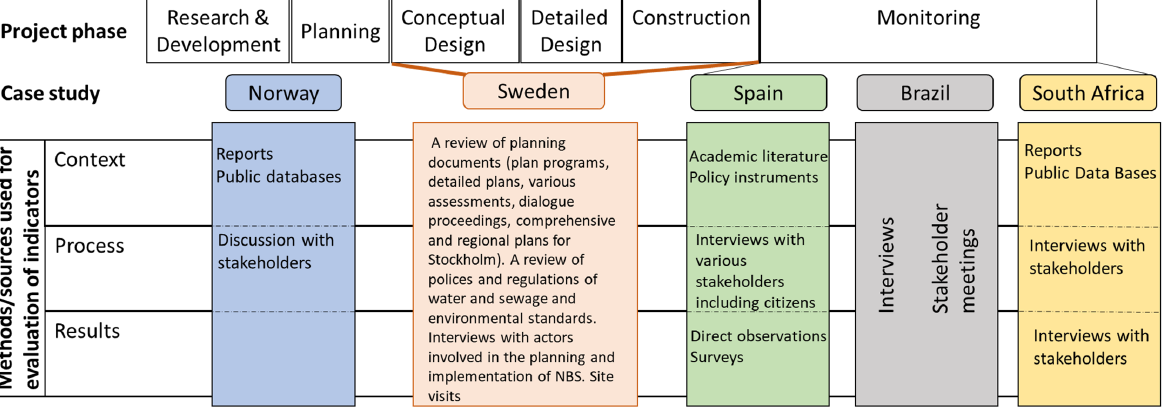
Figure 3. The way in which the case studies are distributed in terms of project phases and the meth- ods used for the definition and evaluation of indicators . methods used for the definition and evaluation of